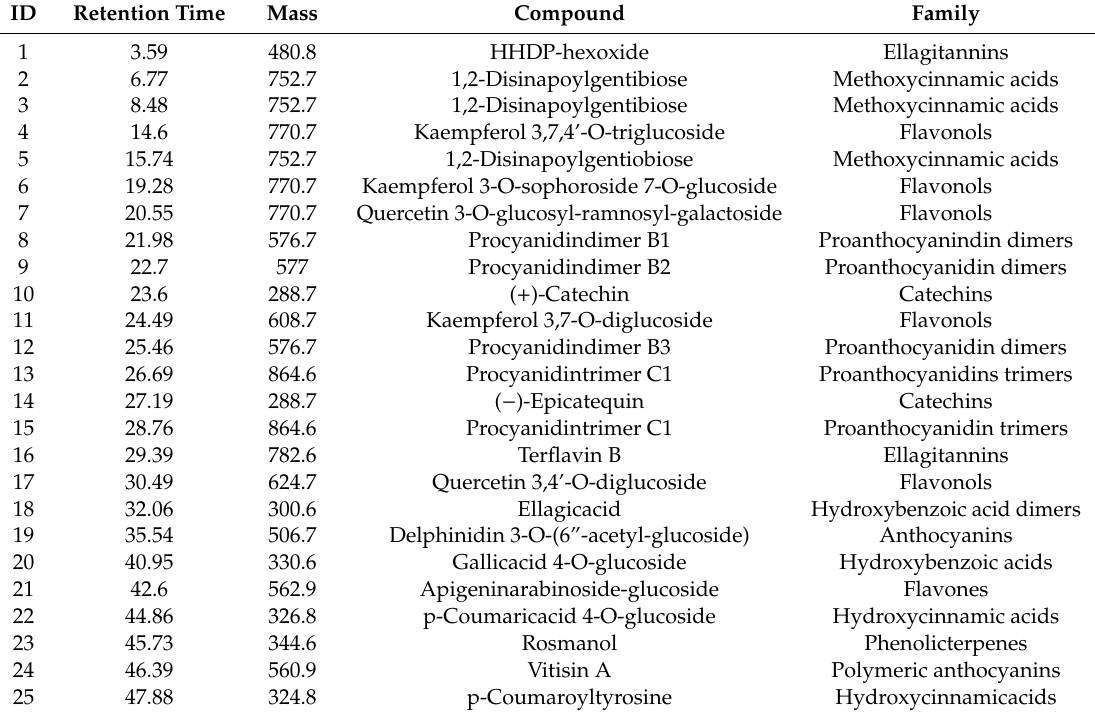
Table 5. Identified compounds from the RP-HPLC-ESI-MS of the solid-state fermentation of Castilla Rose.